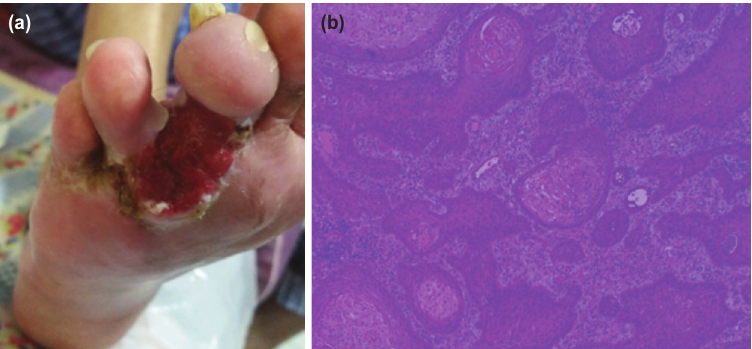
(a) Case 1 on second presentation showing a large fungating ulcer measuring 3 x 2cm over the plantar aspect of the third and Fig. 2: fourth interdigital space. (b) Histology section showing extensive squamous cell carcinoma in situ with no evidence of co-existing melanoma or basal cell carcinoma.